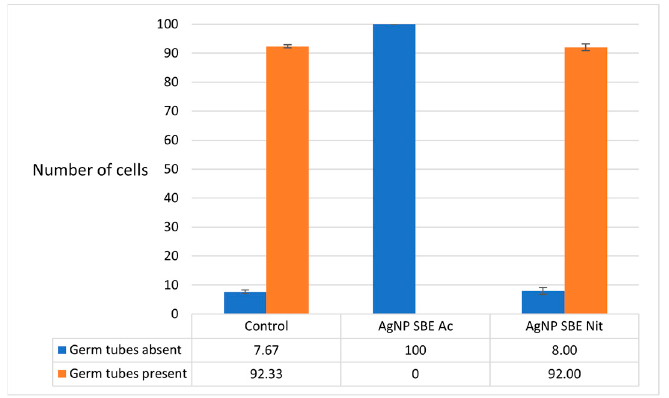
Figure 4. The influence of the AgNP SBEs on the germ tubes production of C. albicans. 2.7. The Influence of the AgNP SBEs on C. albicans Gene Expression for ALS3, SAP2, HSP70 The expression of C. albicans SAP2 gene was down-regulated by the short time (3 h) treatment with MICs of AgNP SBE Ac (FC = 0.42), while the treatment with AgNP SBE Nit presented an indifferent effect for the SAP2 expression (FC = 0.91, over the 0.75 value that was considered as the threshold for down-regulation). The expression of C. albicans